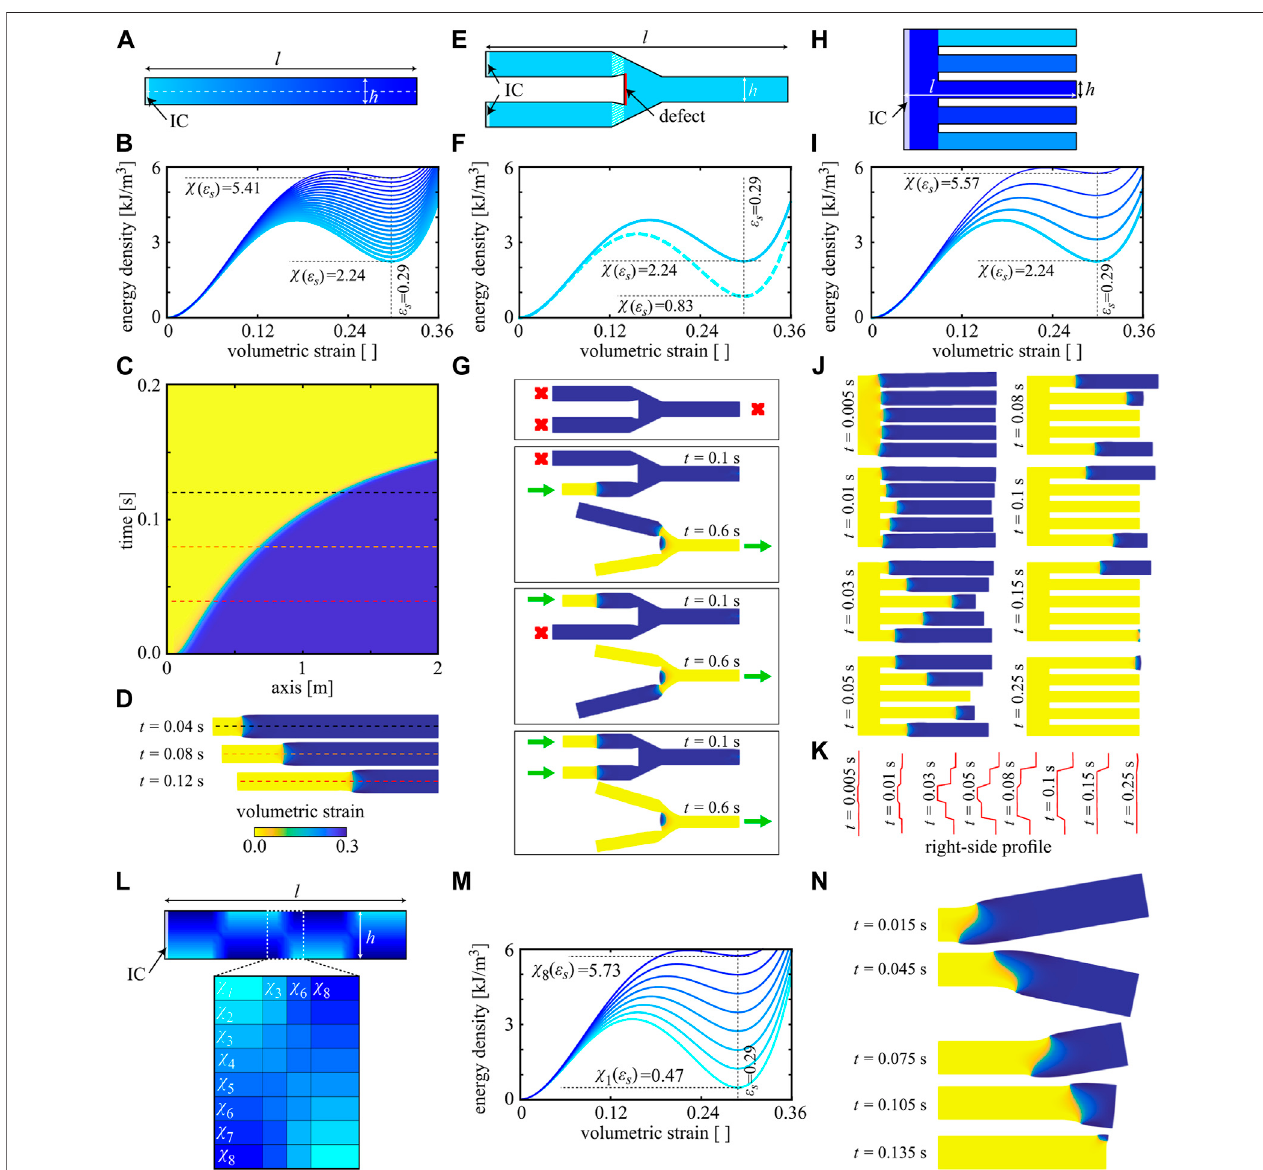
FIGURE4| Transitioneffectsonrecon fi gurability. (A) Aspatiallygradedslab(unitcellsvaryinthehorizontaldirection)withdimensions l (cid:1) 10 h havinglinearlyvarying valuesoftheopen-statestrainenergy (B) alongitslength. (C) Whenimpacted,thestructurerevealsasmoothlyacceleratingtransitioninthe x - t -diagramofthecenterline, with three snapshots of the recon fi guration shown in (D) . (E) A tuning fork-like structure ( l (cid:1) 12 h ) made from two distinct underlying architectures (color code matches with curves in (F) ) and a rigid defect demonstrating OR logic (G) . (H) A comb-like structure ( l (cid:1) 10 h ) made from multiple distinct underlying unit cells (color code matcheswithcurvesin (I) ),whichenablescarefulcontrolofthedelaybetweensignalspropagatingin fi gures (J) andtemporalprogrammingofthesignalarrivalattheright endofthestructure (K) . (L) Arectangularstructure( l (cid:1) 8 h )withalternatingunitcellgradientsalongthelengthandsmoothgradientsalongthewidth(colorcodematching the energydensitiesin (M) ; eight layers along the width and four layers between each section alongthe length). (N) When impacted, the structure undergoes serpentine locomotion. (All results for β / Δ t (cid:1) 0 . 2MPa and μ (cid:1) 1MPa.)